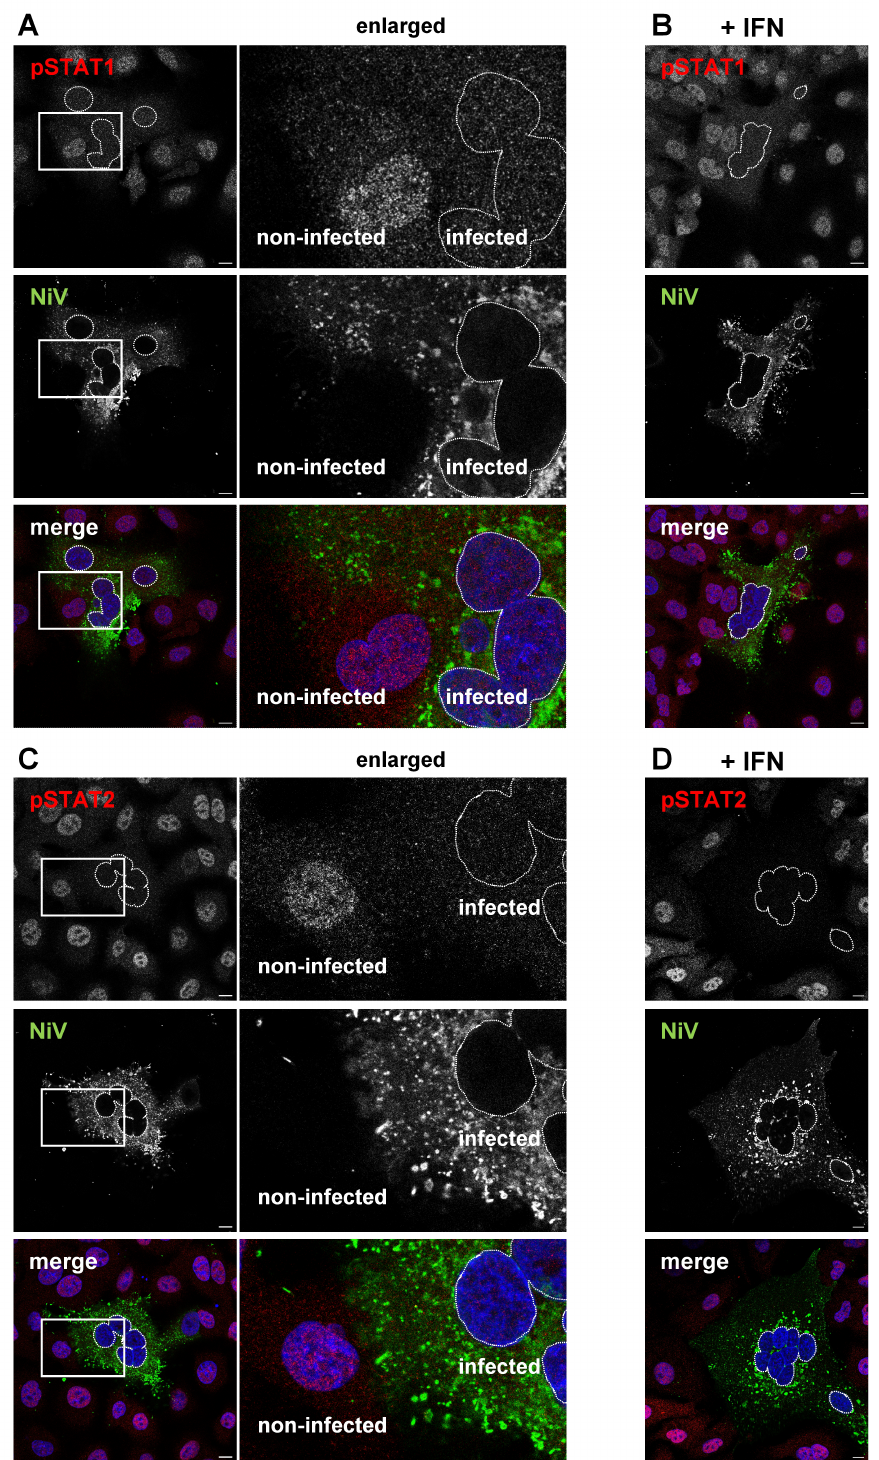
Figure 6. pSTAT formation is prevented in NiV-infected cells. ( A , C ) A549 cells were infected with NiV at an MOI of 10 for 24 h, and then fixed with PFA and permeabilized with ice-cold methanol. To monitor autocrine and paracrine IFN signaling induced by IFNs secreted from infected cells, pSTAT1 ( A ) and pSTAT2 ( C ) were detected with specific antibodies (red). NiV-infected cells were labeled with a NiV N/P-specific antiserum (green), and nuclei were counterstained with DAPI (blue). The greyscale images of the pSTAT and the NiV stainings and the colorized merged images are